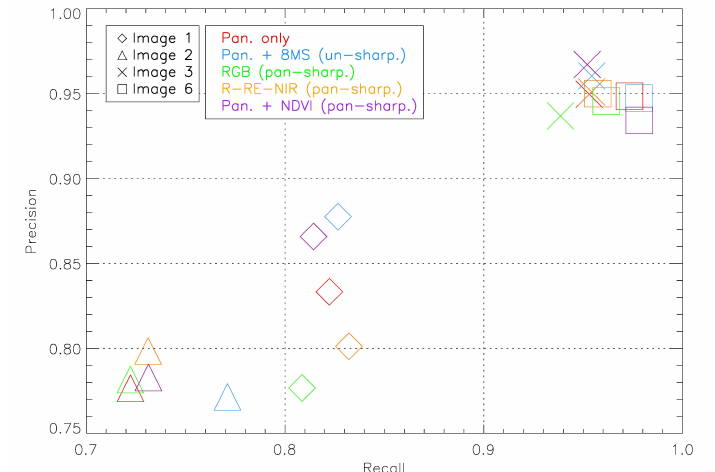
Figure 8. Comparison of precision and recall for different images (symbol type) and models (symbol color). The incorporation of un-sharpened multispectral data generally enhances recall but reduces precision. The worst recall and precision results were generally obtained from the use of pan-sharpened RGB multispectral.